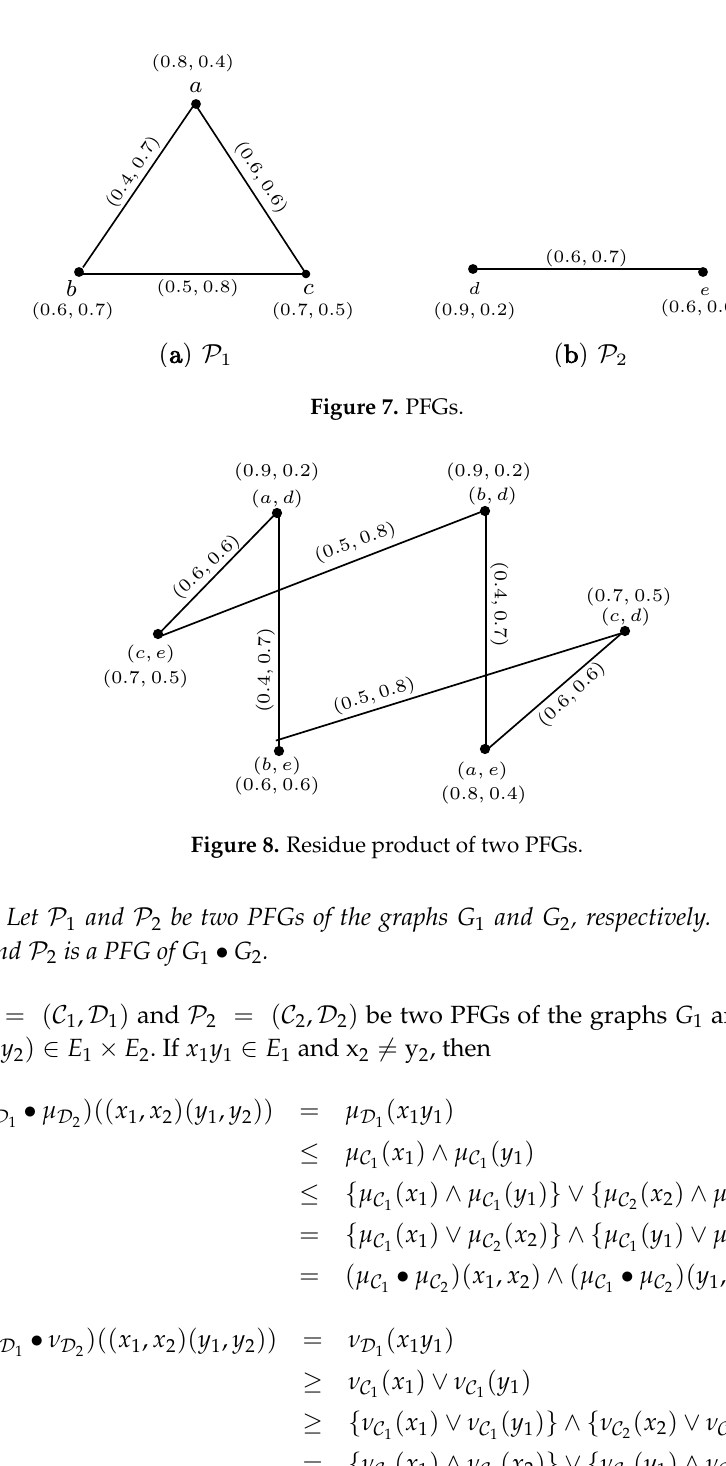
Figure 2.6: PFGs. Figure 7. PFGs.